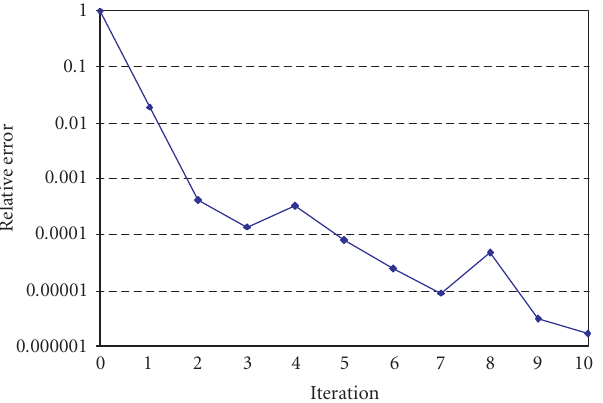
Figure 7: The convergence characteristics of the iteration used in the previous figure. As can be observed, only a few iterations are needed to substantially reduce the reconstruction